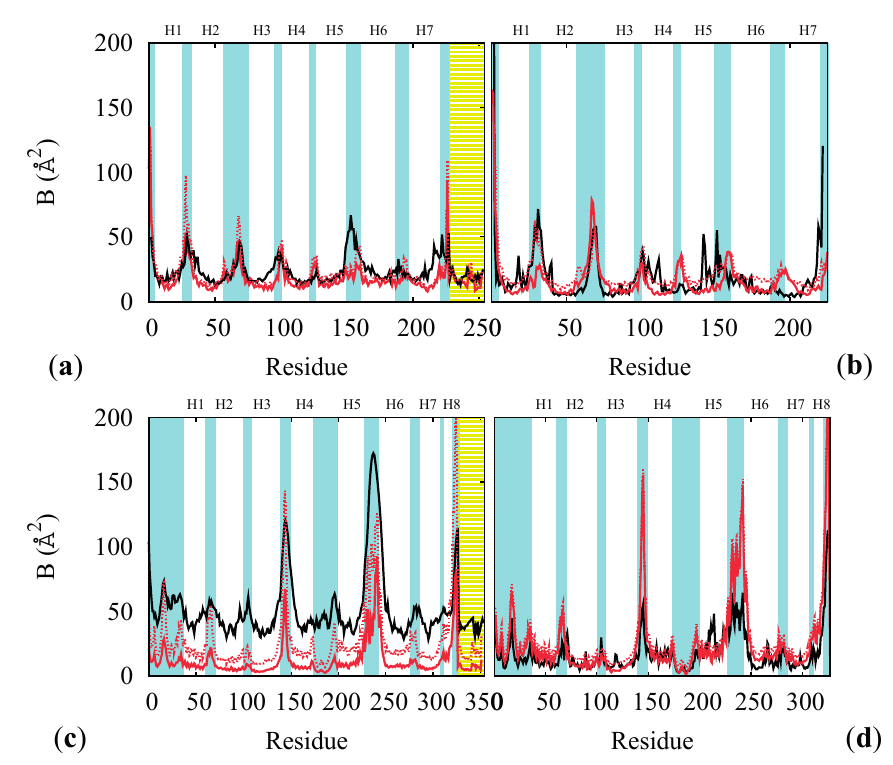
Figure 3. B factors of the rest states of BR ( a , b ), and of MR ( c , d ), at 100 K for the whole proteins (a,c) and at 300 K for opsin only (b,d). Red lines: results from multi-scale simulations with (solid) and without (dotted) containing potential for the membrane. Black lines: experimental data at 100 K ((a) PDB code 1M0K and (c) PDB code 1U19) or from atomistic thermalized simulations of hydrated opsin at 300 K (of BR (b) and of MR (d)). The yellow shade indicates the retinal and the cyan shades the loops regions. The helices are labeled as